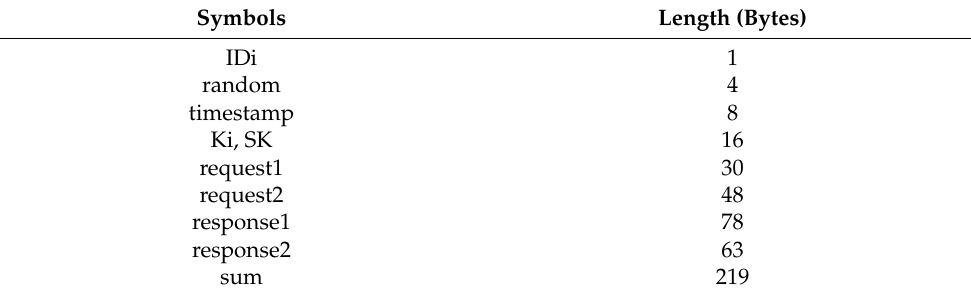
Table 7. Symbols Occupied